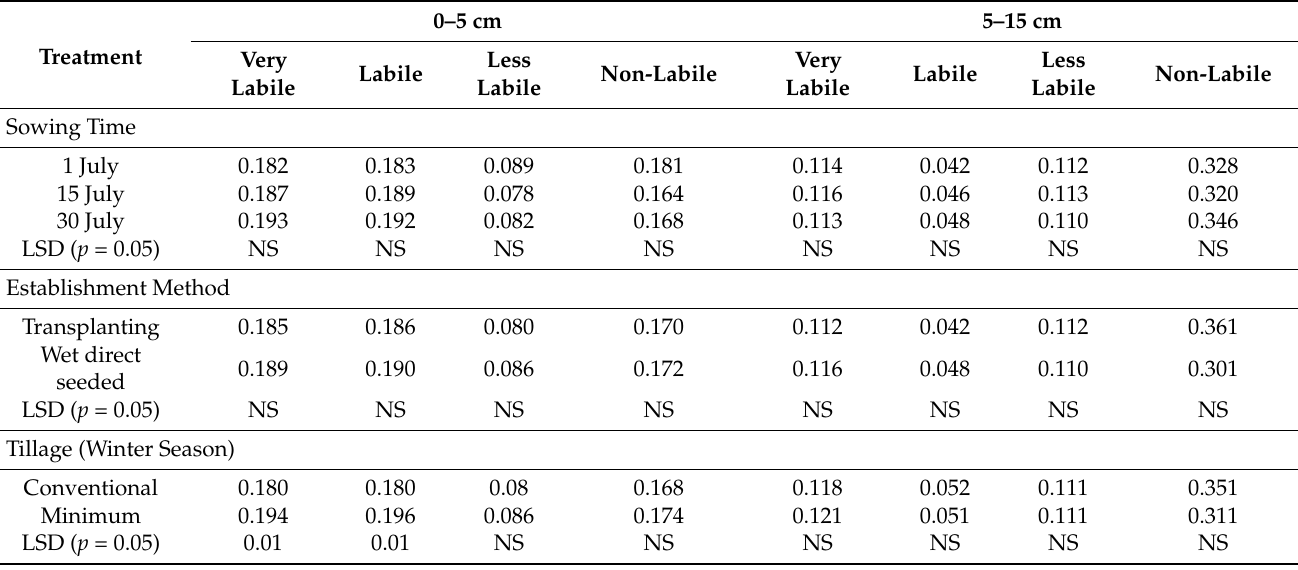
Table 9. Soil organic carbon (%) pools (0–5 cm and 5–15 cm soil layers) in rice–maize cropping system labile carbon during the 5-year period.